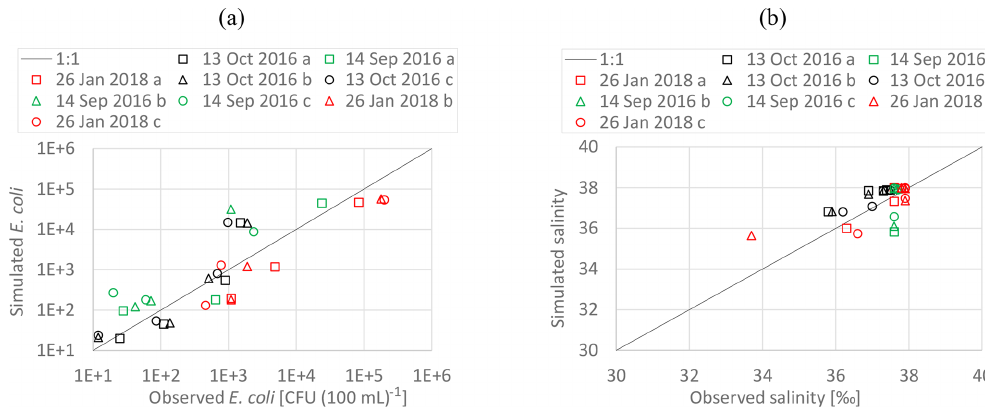
Figure 8. Scatter plots of simulated and observed E. coli concentrations (a) and salinity (b)